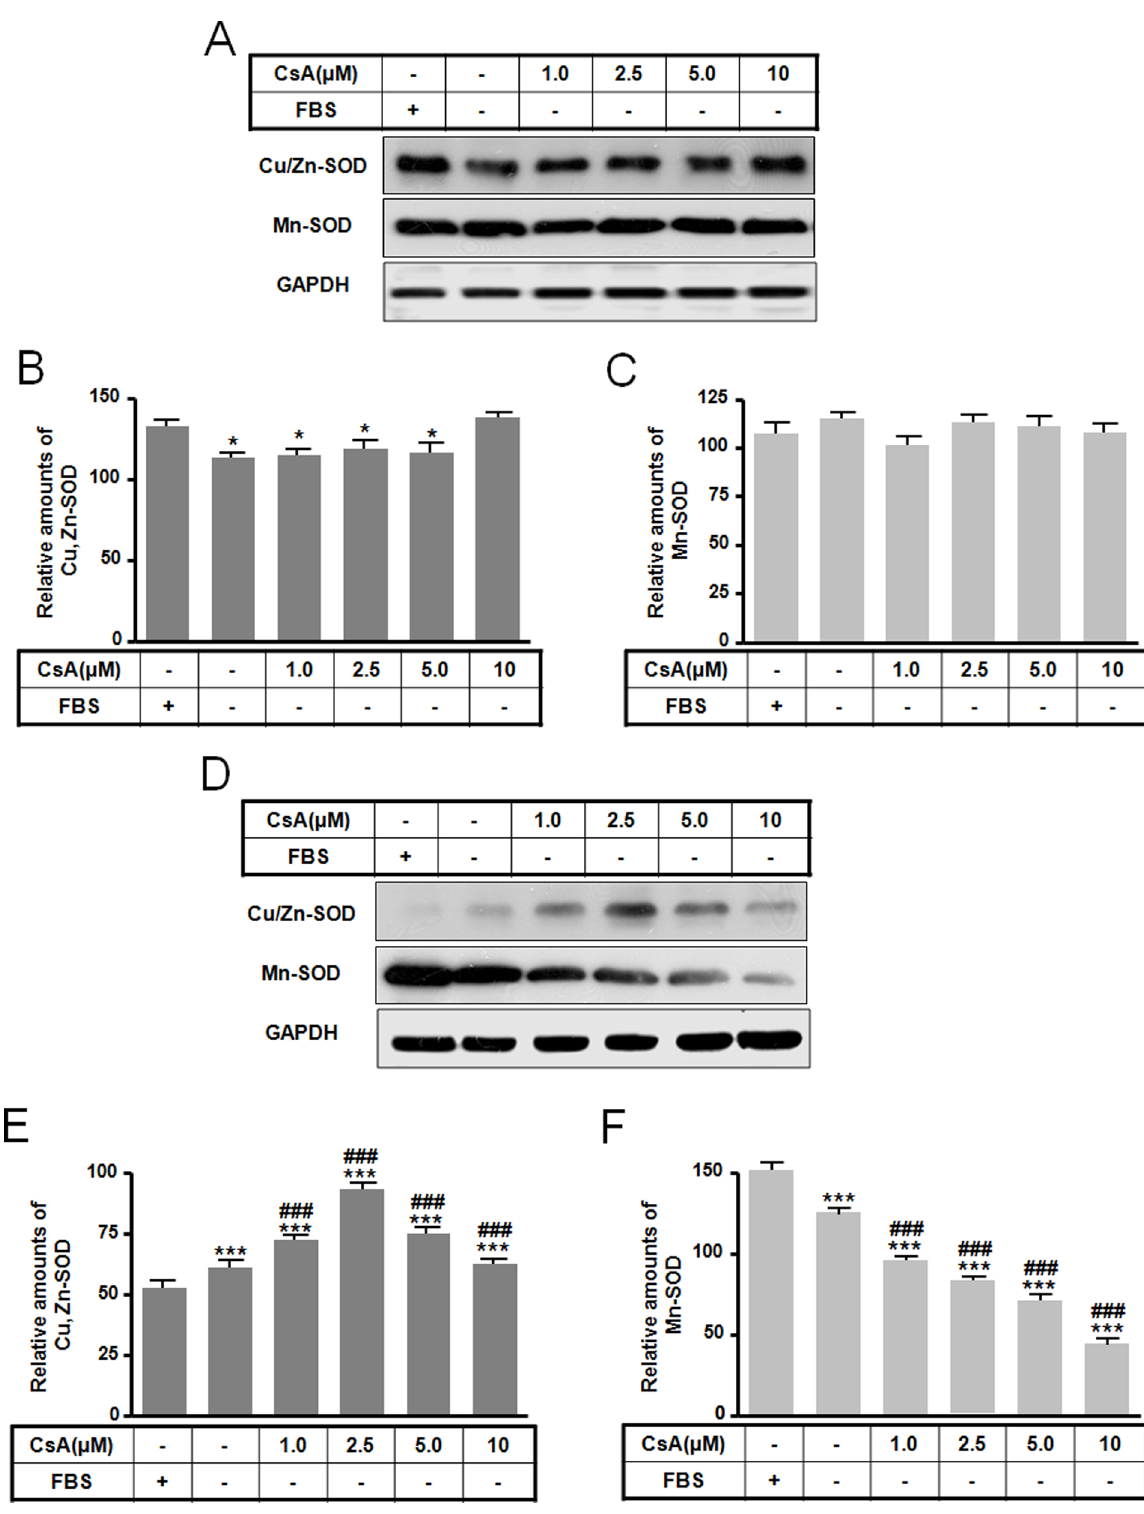
Figure 5. Effect of CsA-mediated autophagic and apoptotic death on Cu/Zn- and Mn-SOD levels. GH3 cells were incubated in DMEM with or without 10% fetal bovine serum in the presence or absence of CsA (0 to 10 m M) for 10 h. Cu/Zn- and Mn-SOD levels for autophagy (A) and apoptosis (D) were determined by Western blotting and the relative amount for autophagy (B, C) and apoptosis (E, F) was calculated as described in the Materials and Methods. * p , 0.05, *** p , 0.001 vs. serum treatment. ### p , 0.001 vs. no serum treatment.